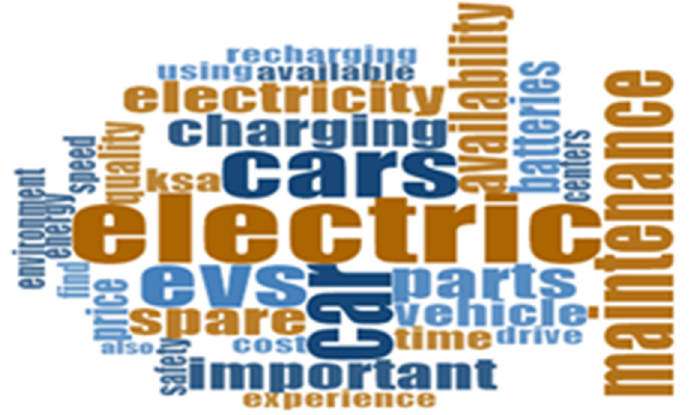
Figure 7. Most repeated words.